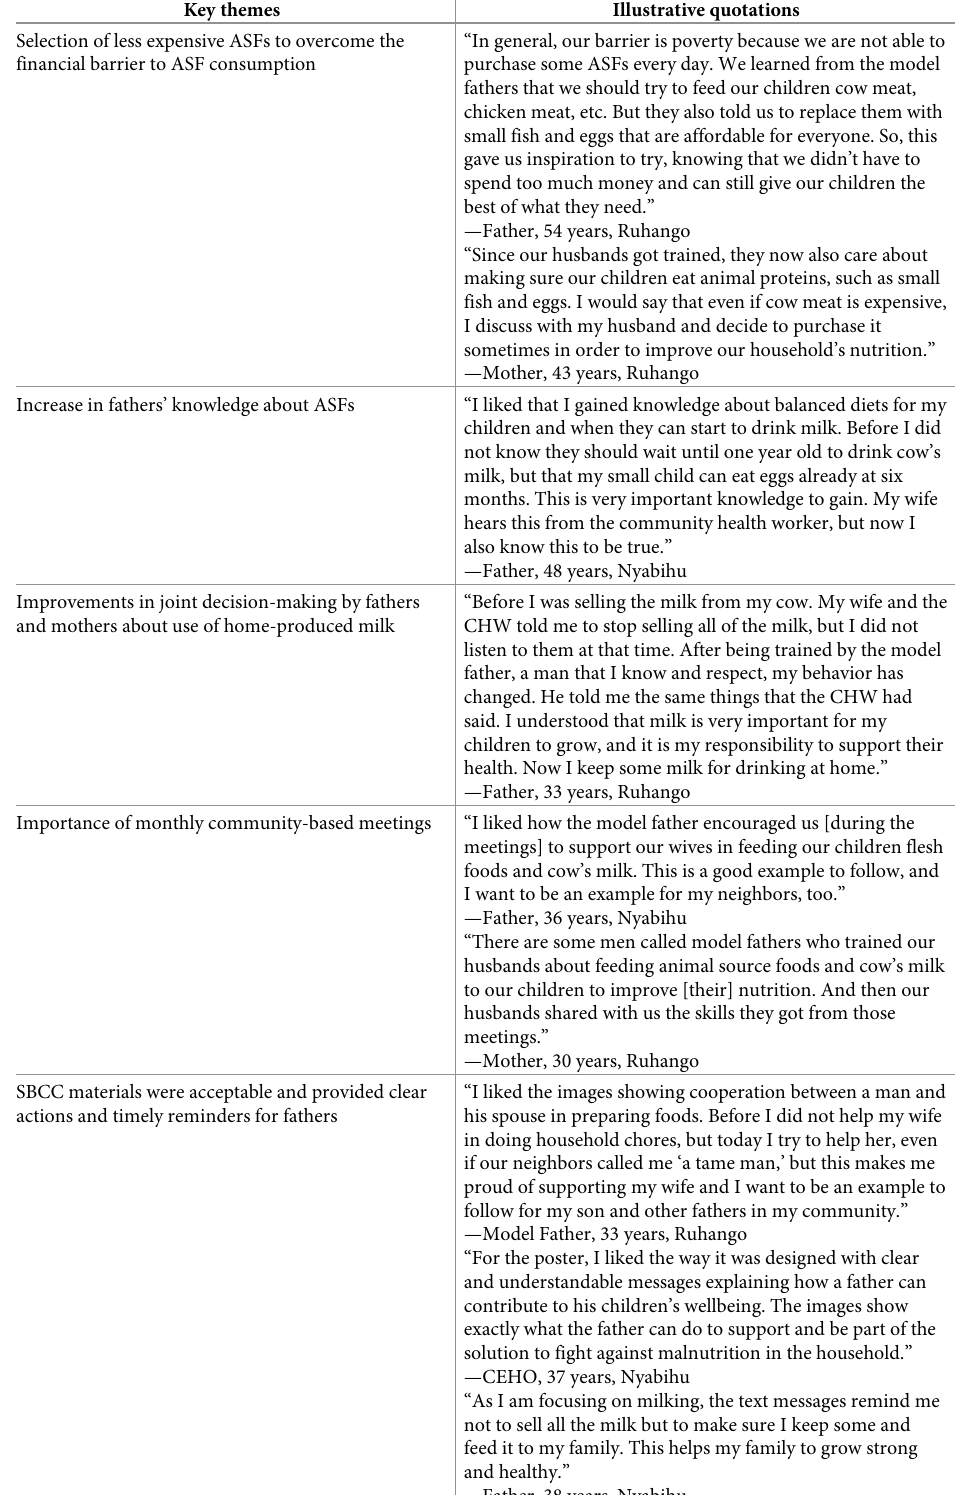
Table 6. Key themes and illustrative quotations from qualitative data collected from fathers, mothers, model fathers, and